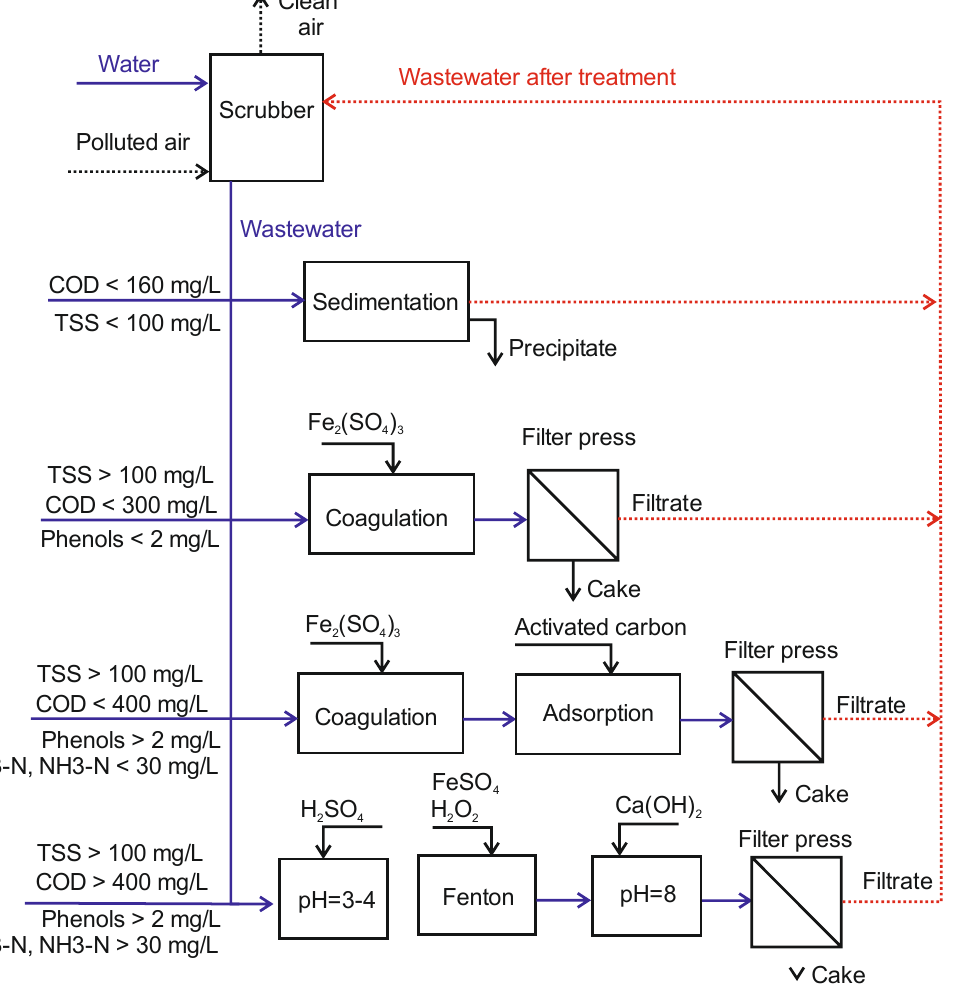
Figure 4. Different treatment pathways available in the WPP (COD: chemical oxygen demand; TSS: total suspended solids; NO 3 -N: nitric nitrogen; NH 3 -N: ammoniacal nitrogen).